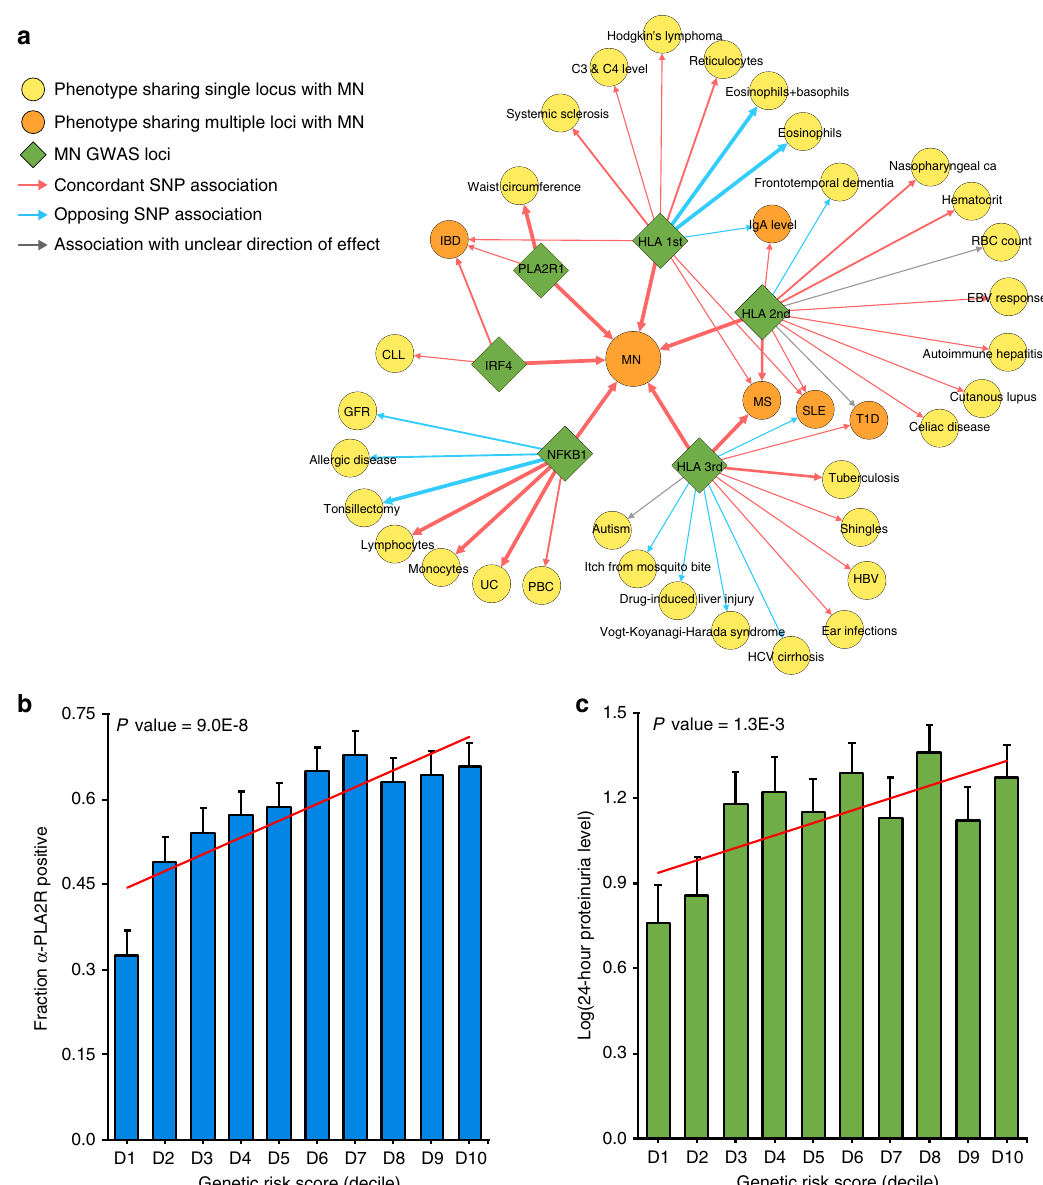
Fig. 5 Pleiotropic effects of the MN loci and their clinical correlations. a The pleiotropy map was constructed based on overlapping genome-wide signi fi cant loci reported in the GWAS Catalogue: traits sharing a single locus with MN are indicated in yellow; traits sharing multiple loci are indicated in orange; arrows represent allelic associations that are identical to, or in tight LD ( r 2 > 0.8) with the MN risk alleles; arrow thickness is proportional to r 2 between alleles; concordant effects are indicated in red and opposed effects in blue. IBD: in fl ammatory bowel disease, includes ulcerative colitis (UC) and Crohn ’ s disease (CD); PBC primary biliary sclerosis, GFR glomerular fi ltration rate, CLL chronic lymphocytic leukemia, HBV hepatitis B virus; b Signi fi cant positive correlation of the GRS with anti-PLA2R antibody seropositivity ( N = 1114 cases, Wald test P = 9.0 × 10 − 8 ) and c log-transformed 24-h proteinuria at diagnosis ( N = 1329 cases, Slope test P = 1.3 × 10 − 3 ). The x -axis depicts deciles of GRS; error bars correspond to standard errors; the P- values are adjusted for age, sex, and